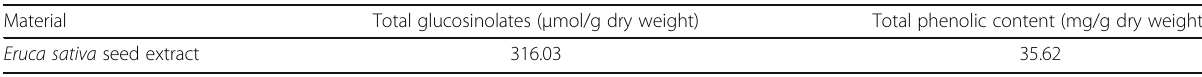
Table 5 Total glucosinolates ( μ mol/g dry weight) and total phenol content (mg/g dry weight) in the seed powder of Eruca sativa